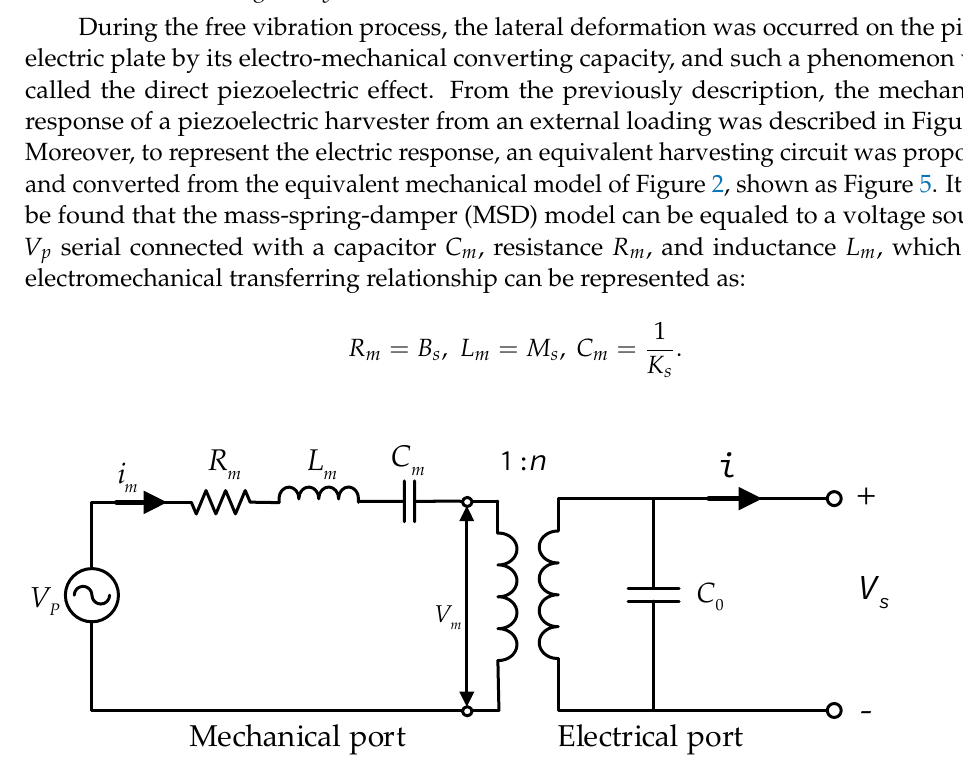
Figure 5. Complete equivalent circuit of piezoelectric cantilever beam structure converted from its electromechanical model [30].